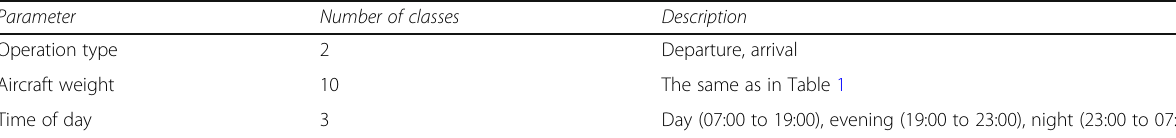
Table 2 Parameters used for classifying existing flight events Parameter Number of